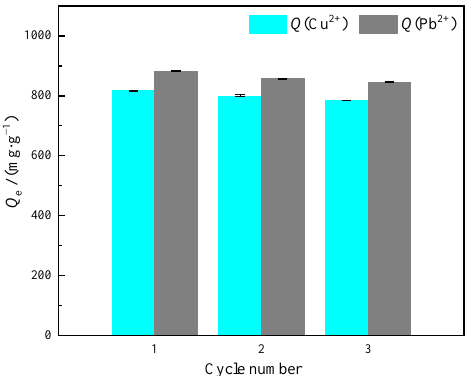
Figure 12. Adsorption – desorption cycles of Cu( Ⅱ ) and Pb( Ⅱ ) on MOMMC.